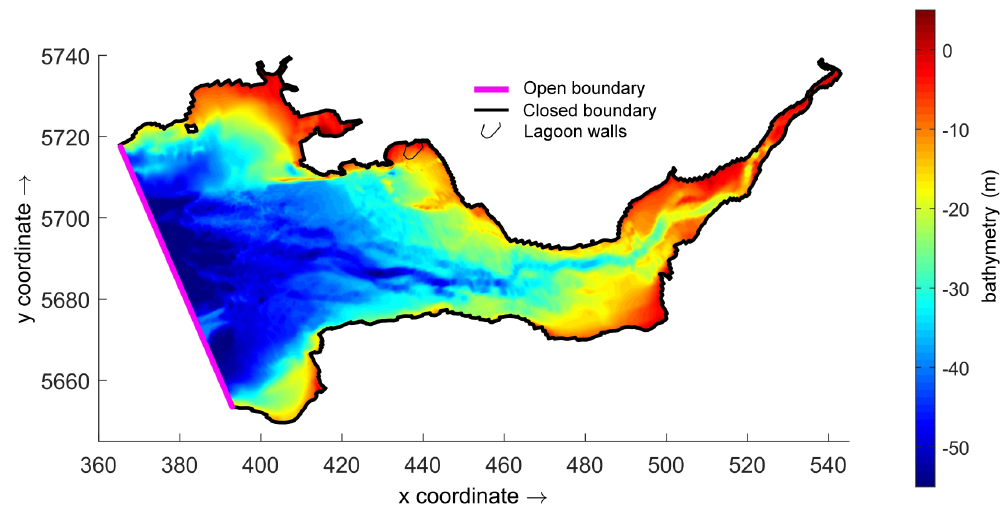
Figure 5. Bathymetry of the Severn Estuary and Bristol Channel obtained from EDINA Digimap